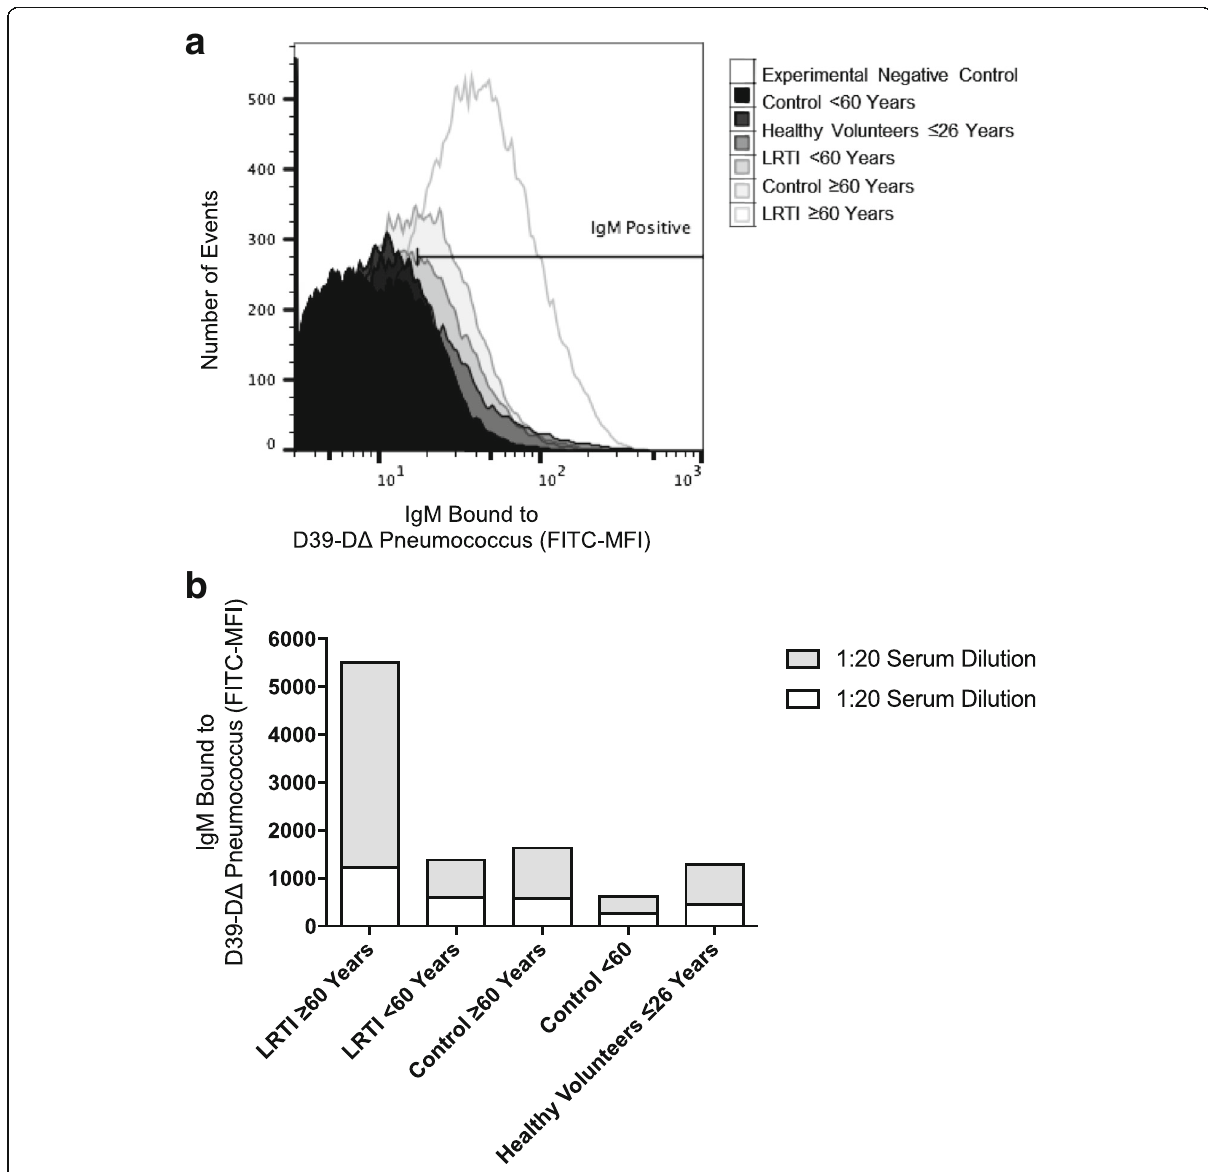
Fig. 3 Flow cytometric assessment of IgM binding to pneumococcus surface. Pooled sera from different volunteer groups were added to bacteria. Two experiments using different dilutions (1:2 and 1:20) of sera were performed. a Histogram of surface binding of IgM to intact pneumococcus D39-D Δ . b Surface binding of IgM from pooled serum samples expressed as the percentage of the bacterial population positive for IgM deposition multiplied by the geometric mean fluorescence of the bacterial population positive for